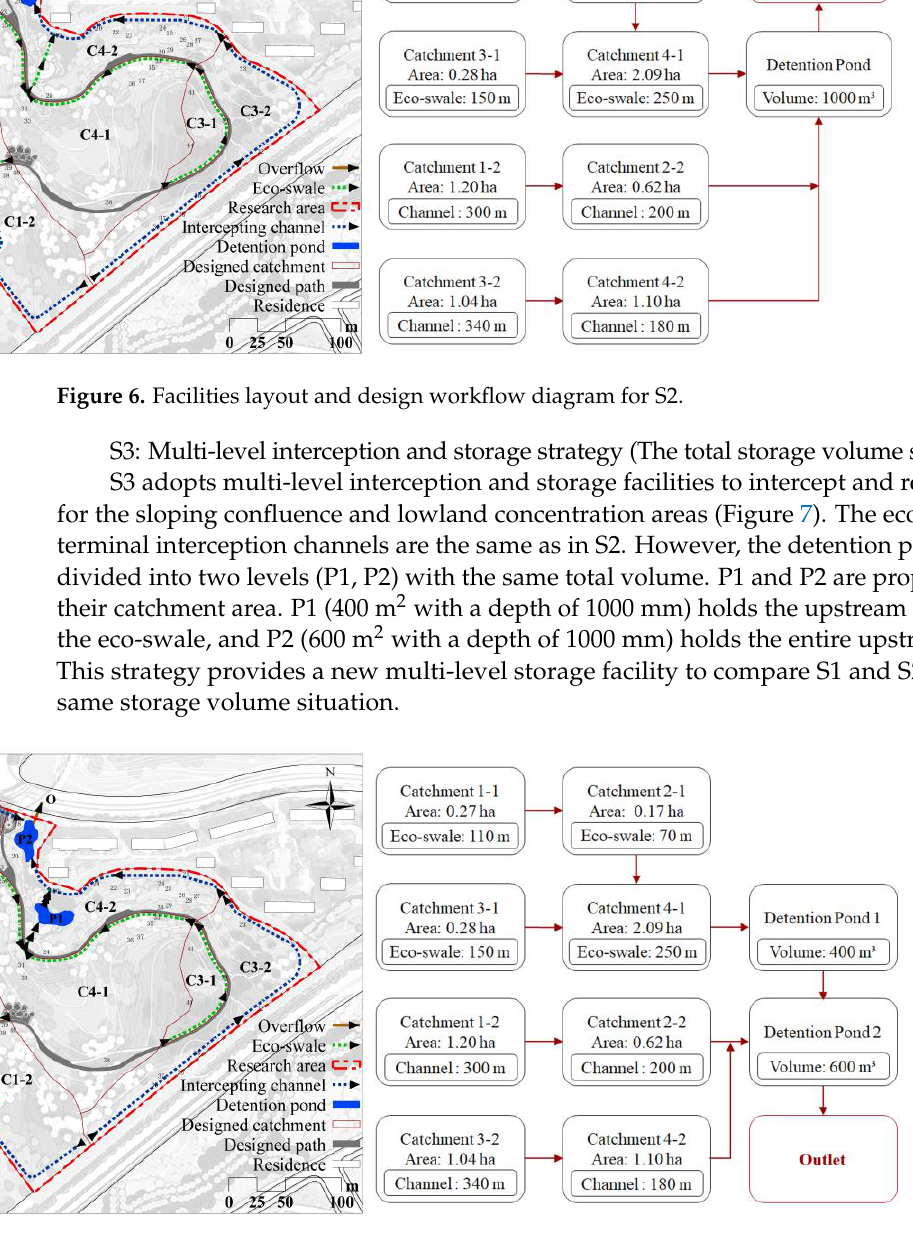
7 of 22 Figure 5. Facilities layout and design workflow diagram for S1. S2: Multi-level interception and terminal storage strategy. S2 adopts multi-level interception and terminal storage facilities to intercept runoff